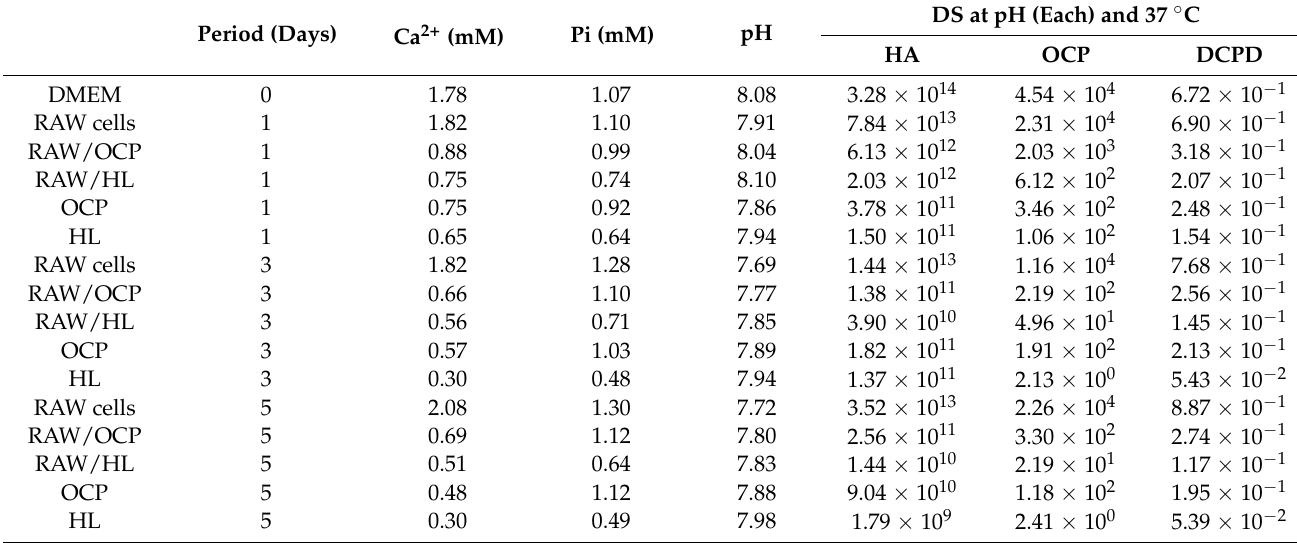
Table 1. Solution composition and degree of supersaturation (DS) of macrophage culture medium before and after the immersion of OCP or HL granules.